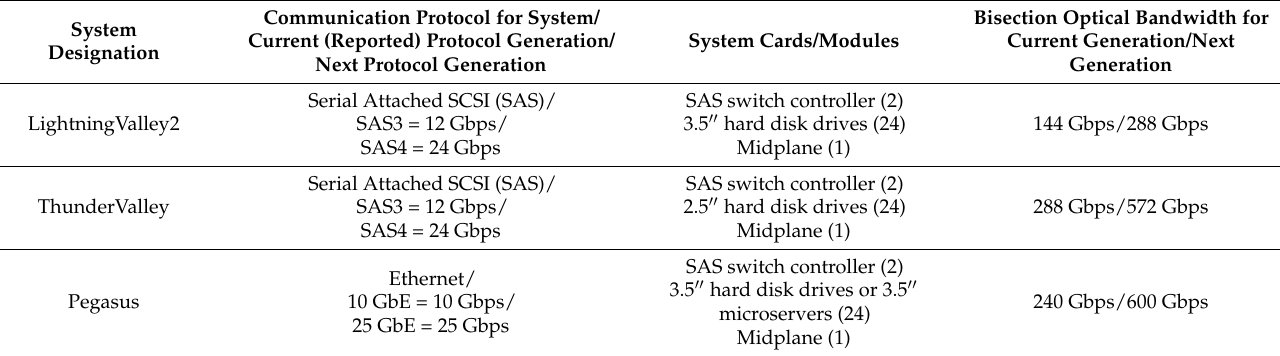
Table 1. Optically enabled data center